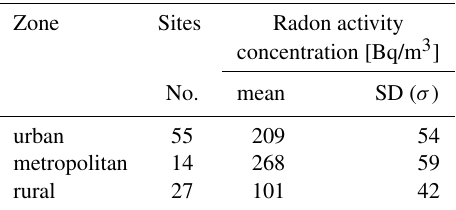
Table 5. Mean value of radon activity concentrations in indoor air at the basement/ground floor vs. first